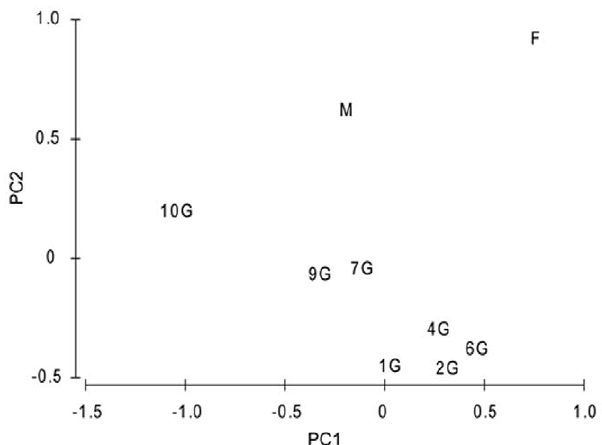
Figure 10. PCA ordination of environmental variables. Principal component analysis normalized environmental data from stations along the Ellett Line transect. Parameters included are temperature, salinity, density, phosphate, silicate and nitrate from the upper 100 m of the water column. The majority (60.4%) of the variance in the data was explained by the principal component 1 (PC1), while component 2 (PC2) accounted for 36.9%, giving a total explained of variation 97.3% from these two axes alone (Table 2).